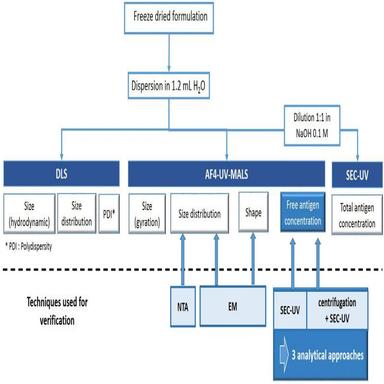
Analytical procedures applied to the loaded nanoformulation.